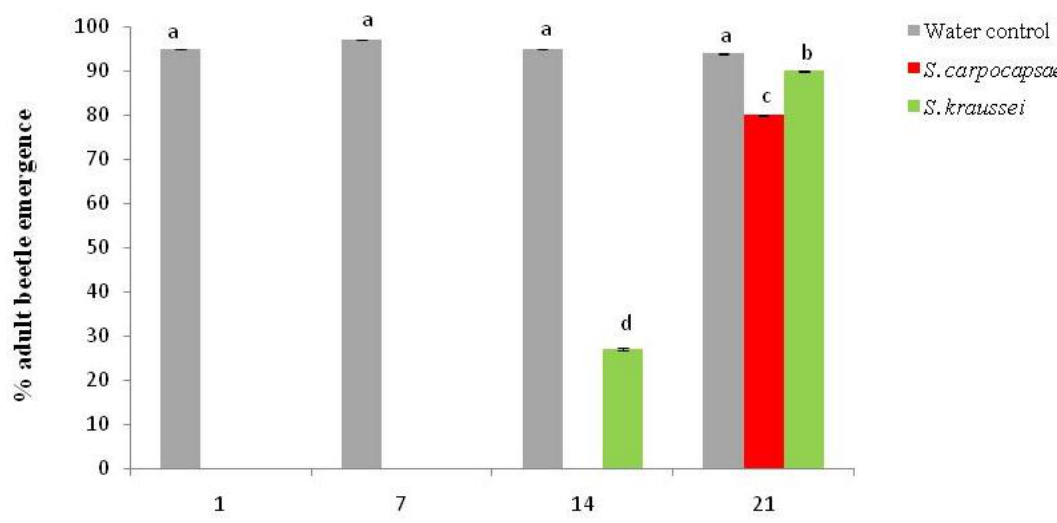
Figure 4. Impact of sequential applications of entompathogenic nematodes on Aethina tumida wandering larvae following their submergence in sand. Beetle emergence assessed after 6 weeks following larvae being added to sand. Error bars represent the 95% confidence intervals. Means were separated using least significant differences after adjusting for multiple comparisons. Significantly different means (5% significant level) are represented by suffixes a (cid:177)